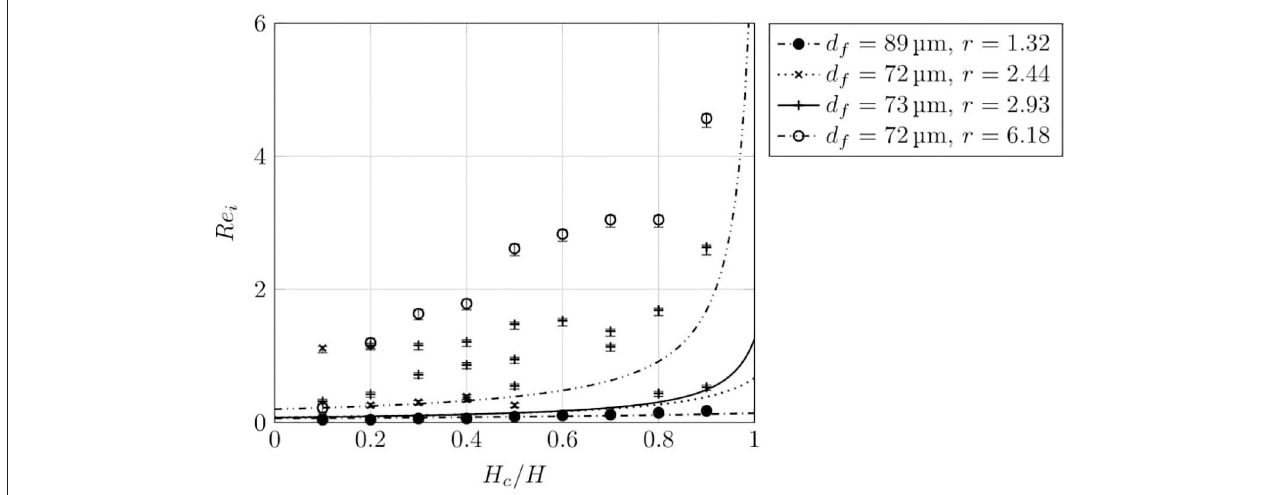
FIGURE 9 | Dependence of initiation Reynolds number on relative coarse layer thickness for several beds consisting of mixtures of particles as specified in Table 2 . All the beds had an overall thickness H = 10cm. The curves describe Equation 10 and the points are experimental measurements.